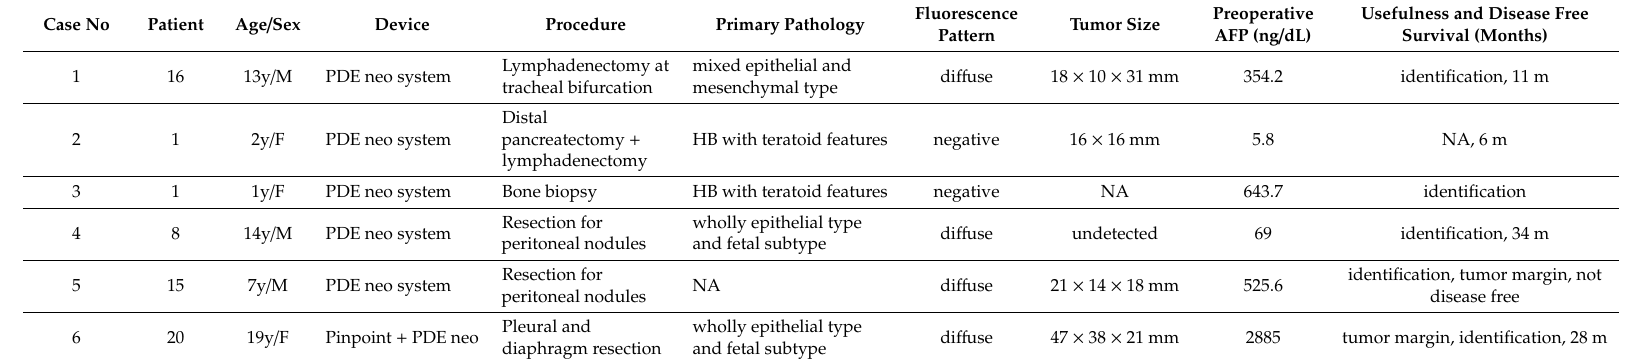
Table 3. Other surgeries for distant metastases, except for those to the lungs. HB: